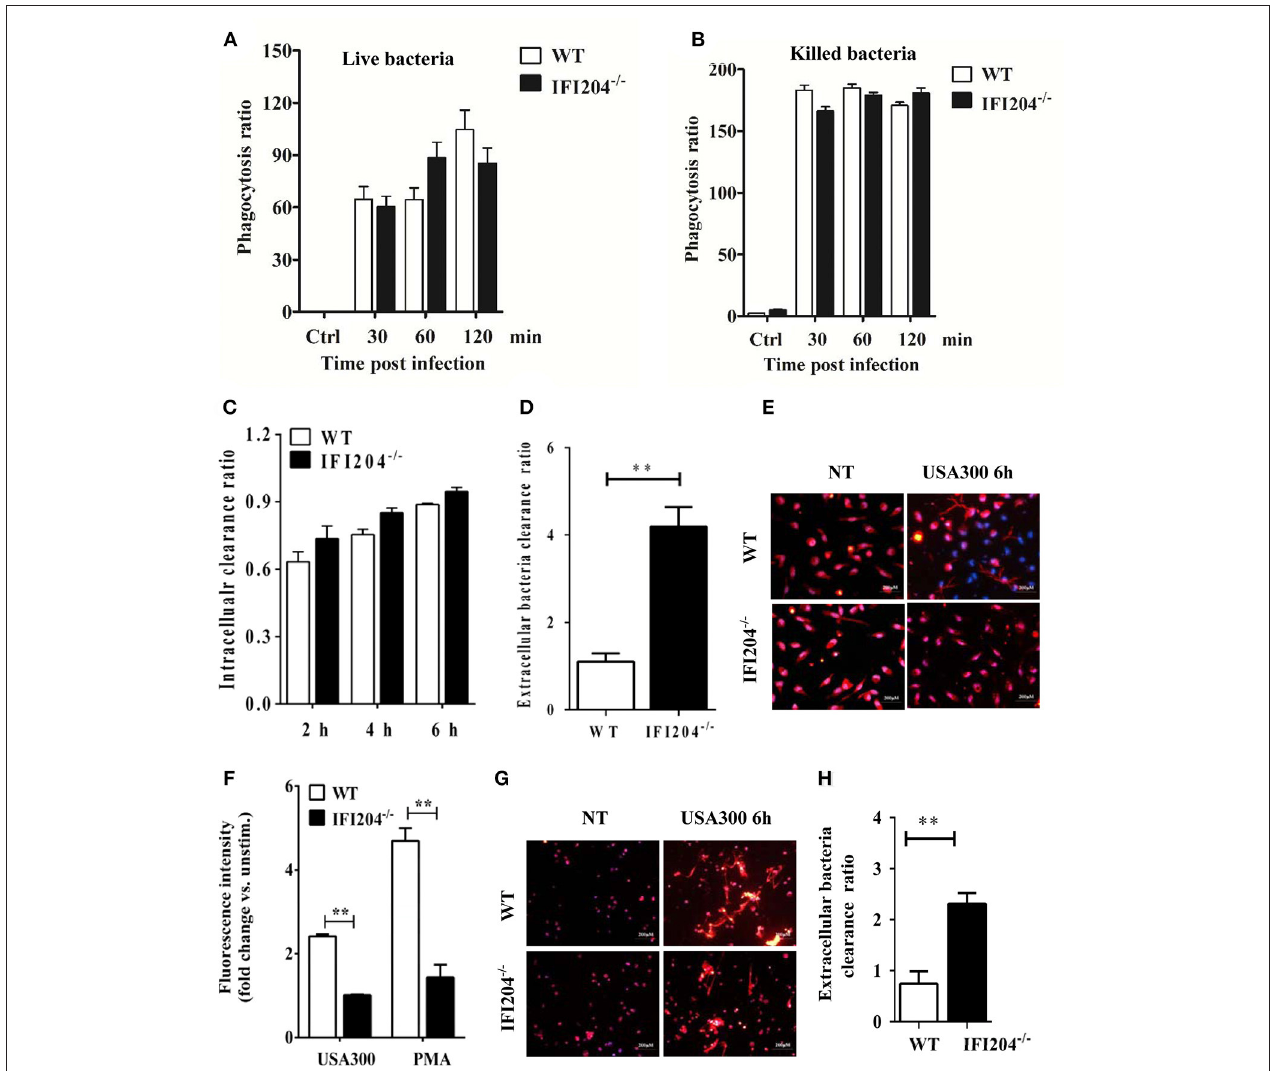
FIGURE 7 | IFI204 promotes extracellular trap-mediated bacteria killing in macrophages and neutrophils. Macrophages were treated with FITC-labeled live (A) or killed bacteria (B) . The mean fluorescence intensity (MFI) of the FITC-positive cells were determined by flow cytometry. (C) Macrophages were infected with bacteria (MOI = 5) for 1h. Non-engulfed bacteria were killed with gentamicin. The cells were lysed and intracellular bacterial were enumerated by plating on agar plates. (D) Extracellular bacterial killing capacity of macrophages were determined by assessing extracellular CFUs. (E) Macrophages were challenged with bacteria (MOI = 50) for 6h. Representative microscopy pictures of NETs formation as indicated by SYTOX Orange. (F) Macrophages were stimulated with bacteria (MOI = 50) and PMA (100nM). SYTOX Orange was added after 6h and fluorescence was measured by spectrofluorometry. (G) Neutrophils were challenged with bacteria (MOI = 50) for 6h. Representative microscopy pictures of NETs formation as indicated by SYTOX Orange. (H) Extracellular bacterial killing capacity of neutrophils were determined by assessing extracellular CFUs. All data are shown as mean ± SEM. Student’s t -test was performed. ** p <